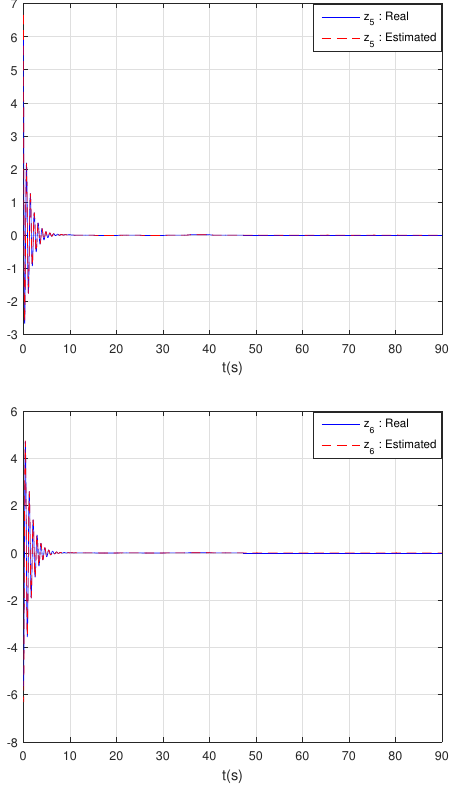
Figure 3. z 5 and z 6 with their estimates.